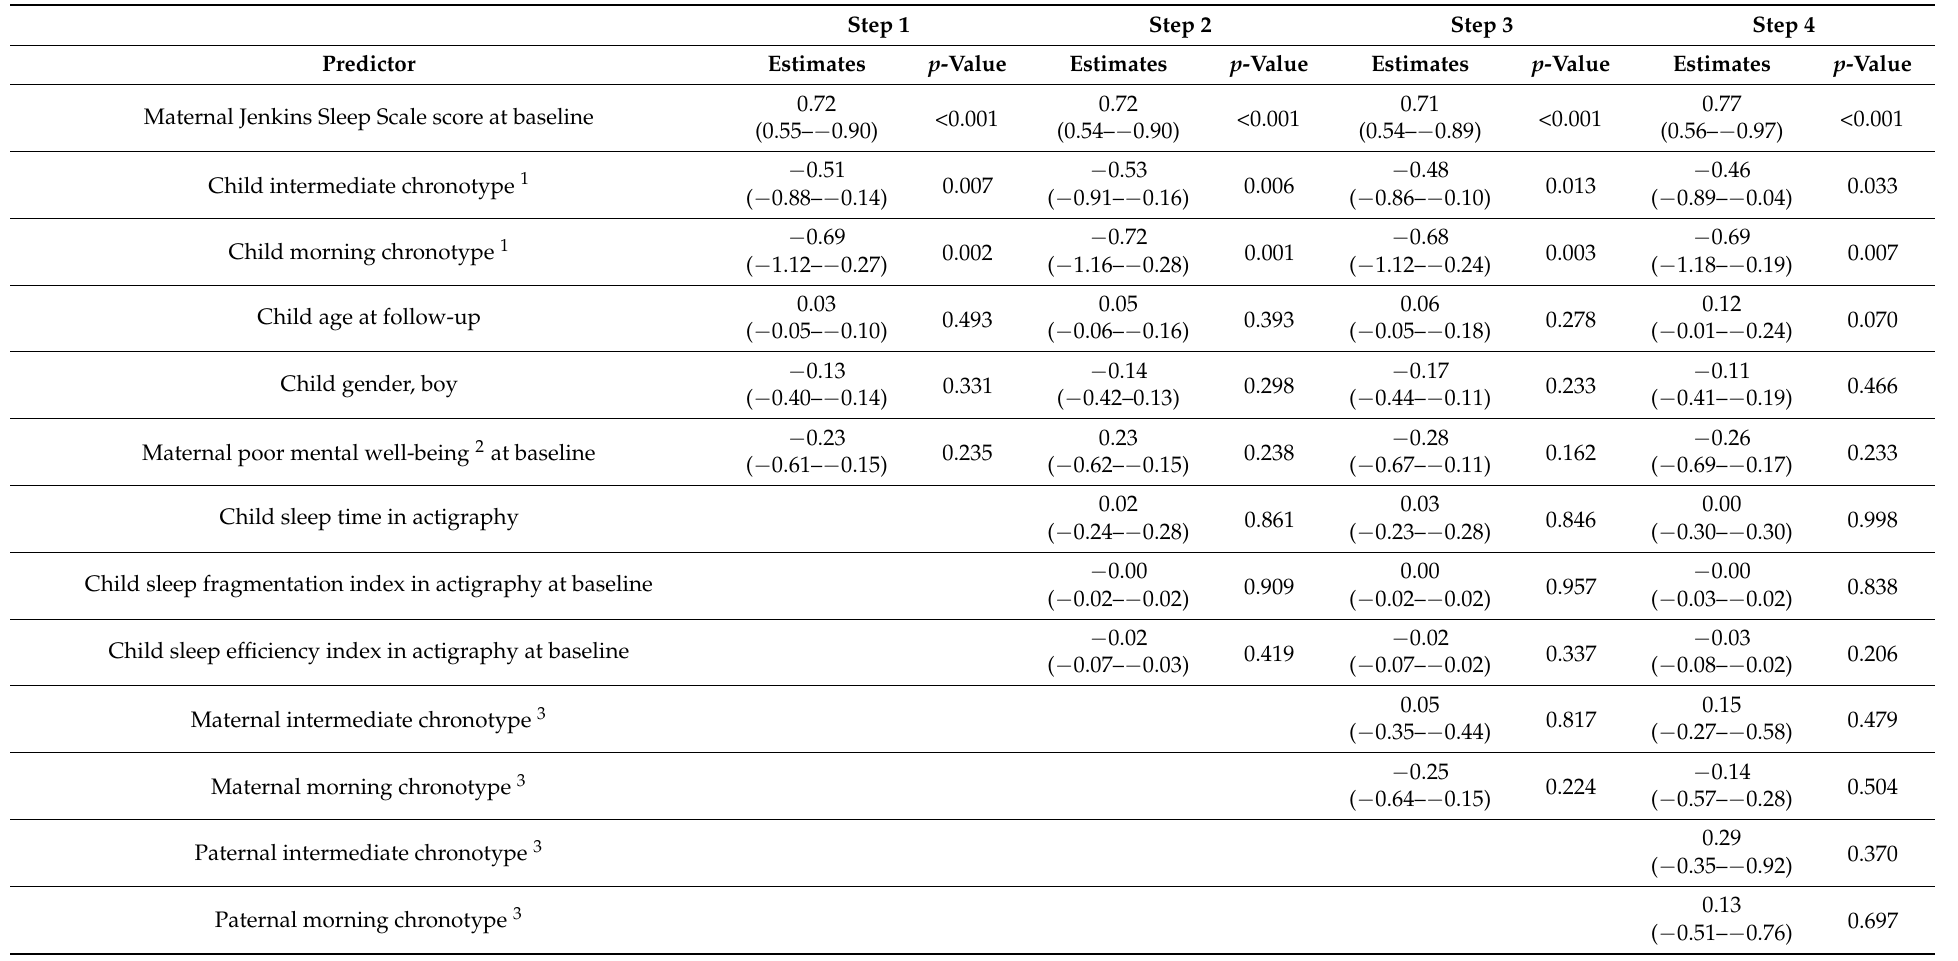
Table 3. Effect of different variables on maternal sleep assessed using the Jenkins Sleep Scale score at 1-year